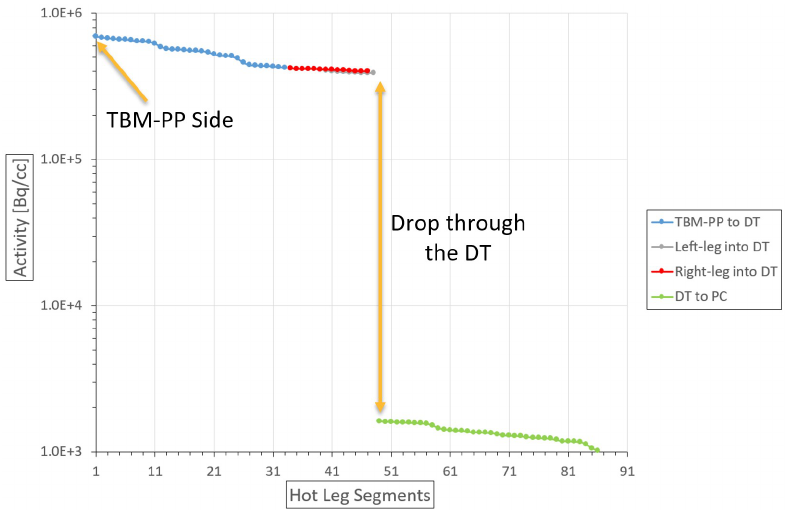
Figure 10. 17 N Activities [Bq cm − 3 ] in pipe segments.